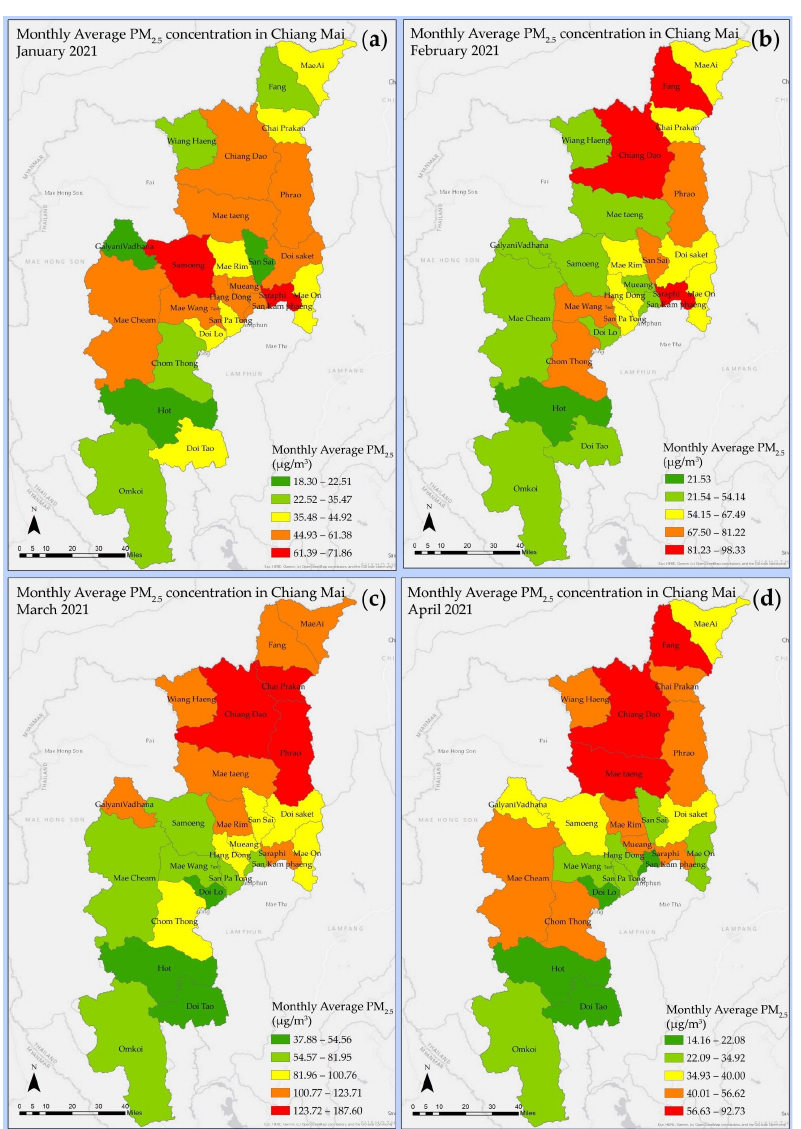
Figure 2. The spatial distribution of PM 2.5 across Chiang Mai during January-April 2021 ( a ) January, ( b ) February, ( c ) March, and ( d ) April.